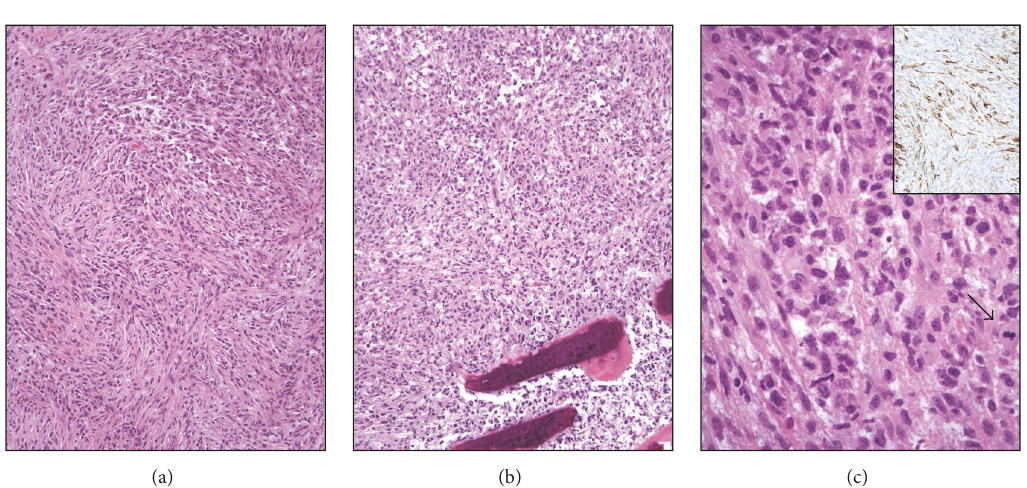
Figure 1: Morphologic features of the original dura/calvarium lesion. (a–c) H&E staining demonstrates a malignant spindle and epithelioid cell neoplasm with increased mitotic activity ((c), arrow) and necrosis (not shown). A large panel of immunostains, including markers of both epithelial and mesenchymal differentiation, was negative, except for focal expression of SMA